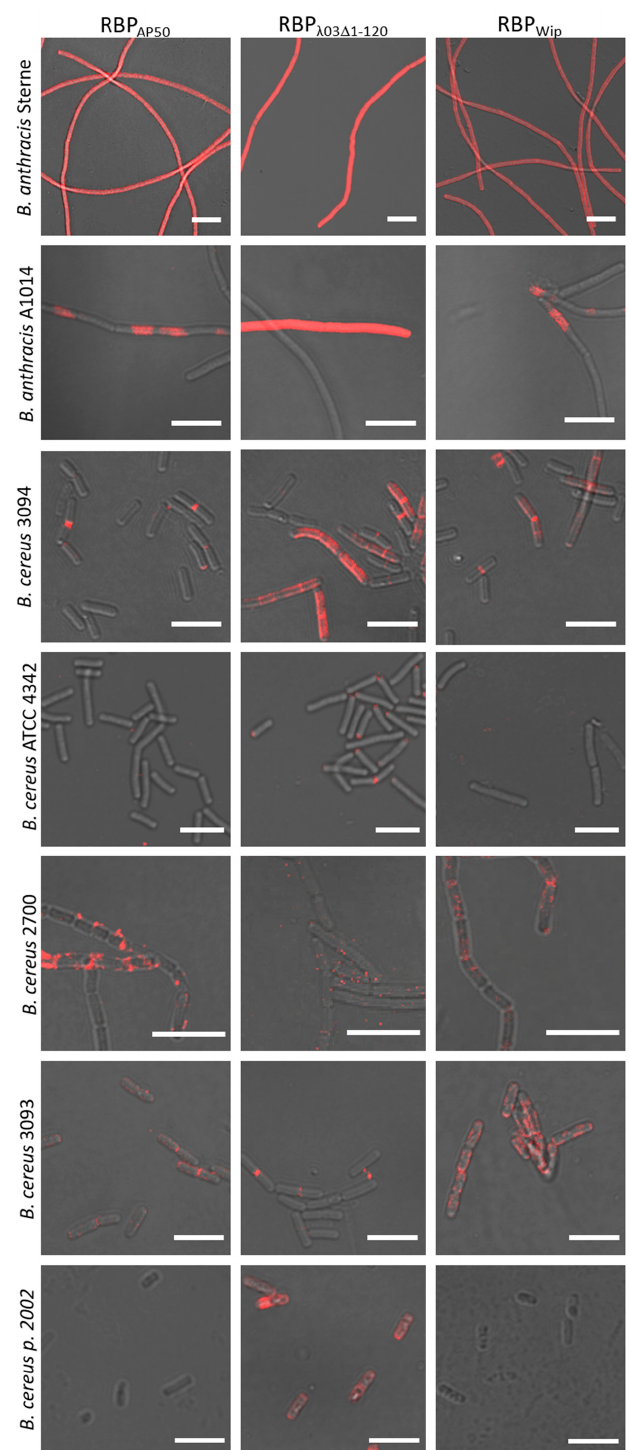
3 Figure 7. Binding of RBP reporters to cells of non- anthracis bacilli. Fresh cultures inoculated from overnight cultures of representative strains from Table 3 were grown for 2 (for labeling with RBP λ 03 ∆ 1-120 ) or 4 h (for labeling with RBP AP50 or RBP Wip ), incubated with RBP reporters (RBP AP50 , RBP λ 03 ∆ 1-120 or RBP Wip ) and subjected to fluorescence microscopy. Representative micrographs were recorded as merged light and red fluorescence channel. Cells of B. anthracis Sterne and A1014 served as genuine positive examples. Scale bars: 10 µ